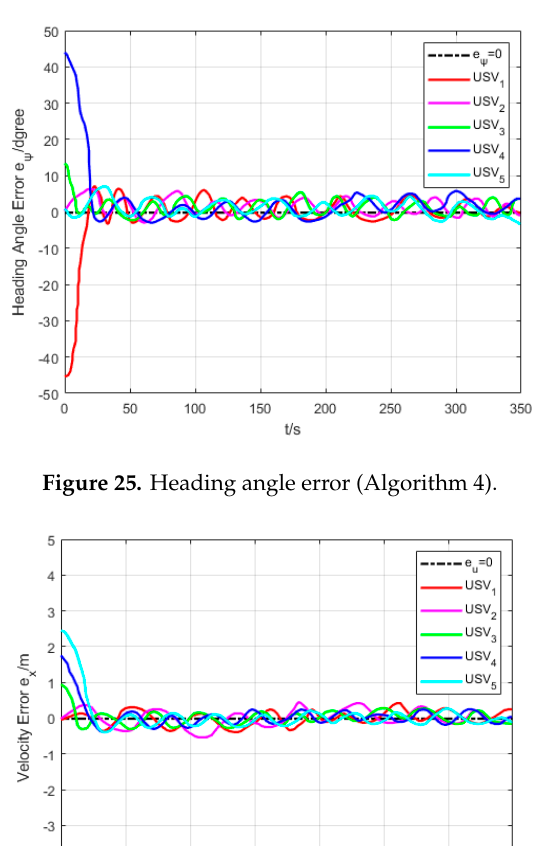
Figure 24. Longitudinal error (Algorithm 4).